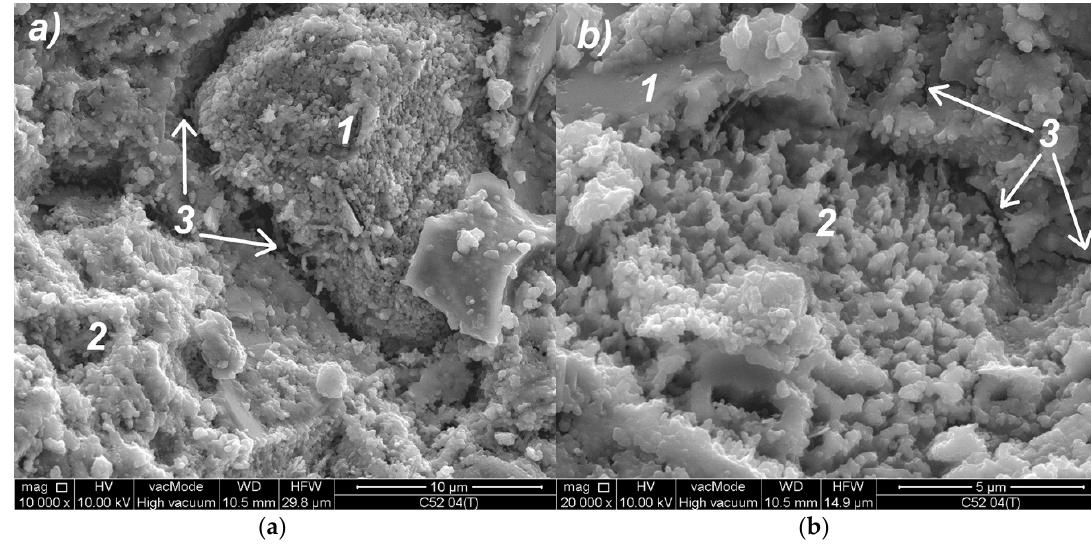
Figure 8. SEM images of the C52 cement paste microstructure: ( a ) Magnification 10,000×; ( b ) magnification 20,000×; descriptions of the indications in the text.